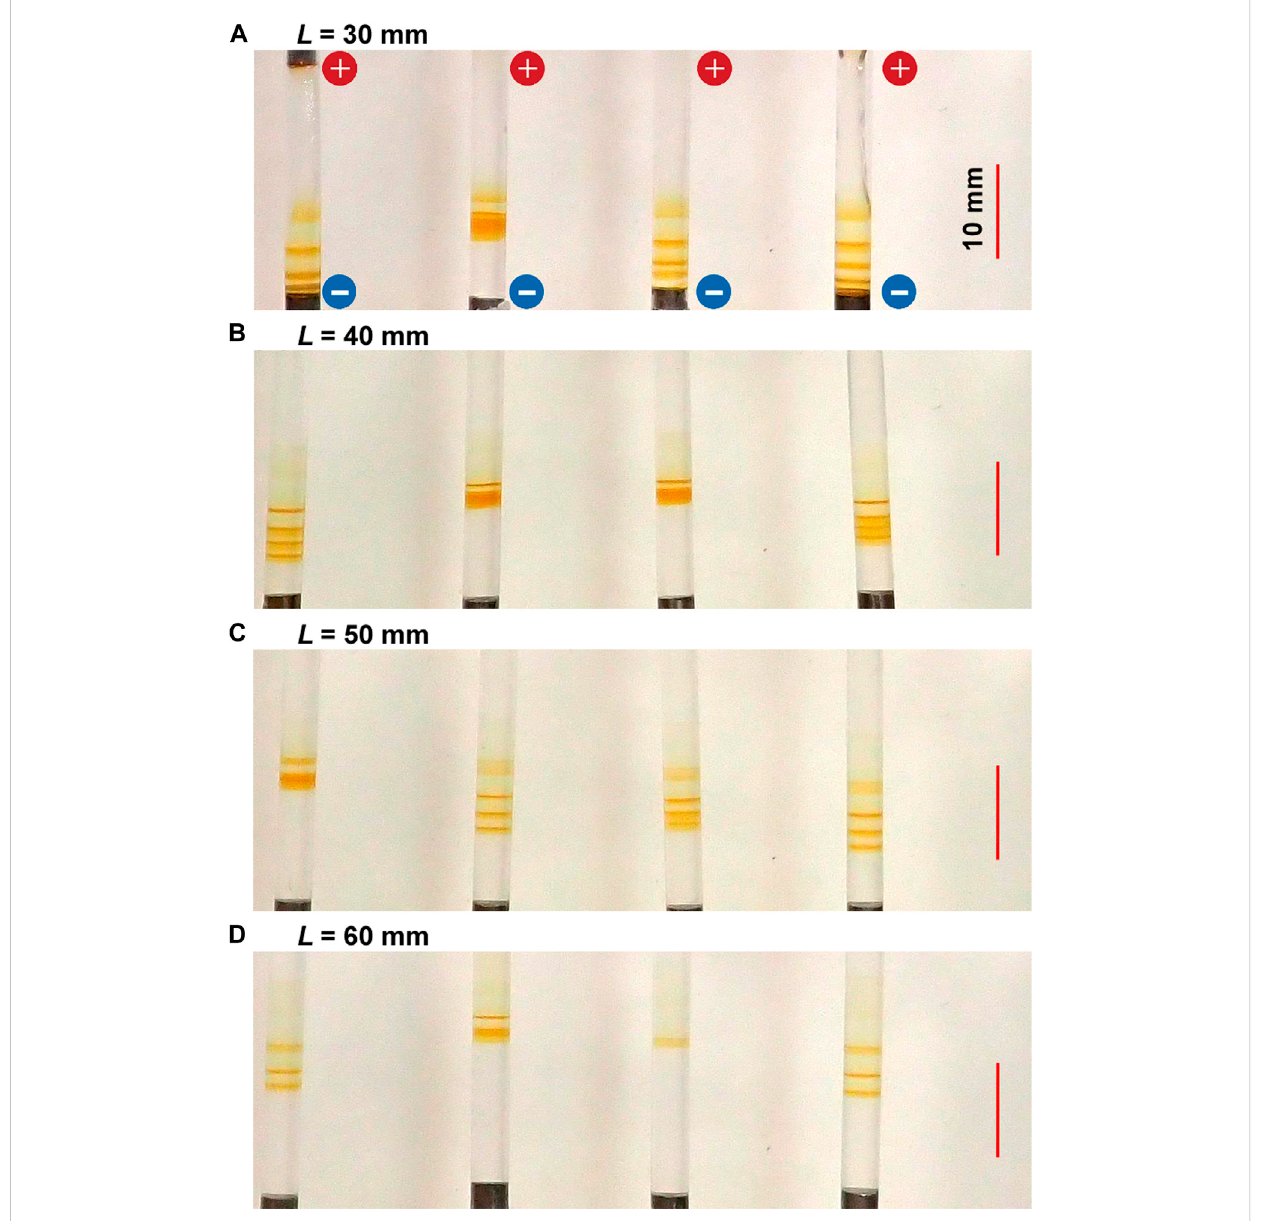
FIGURE 8 Typicalperiodicbandsformedinthefourgelcolumnswithvariouslengths( L )at25 ° Cundertheappliedcyclicalternatingvoltages( E H =4 V, E L =1 V,